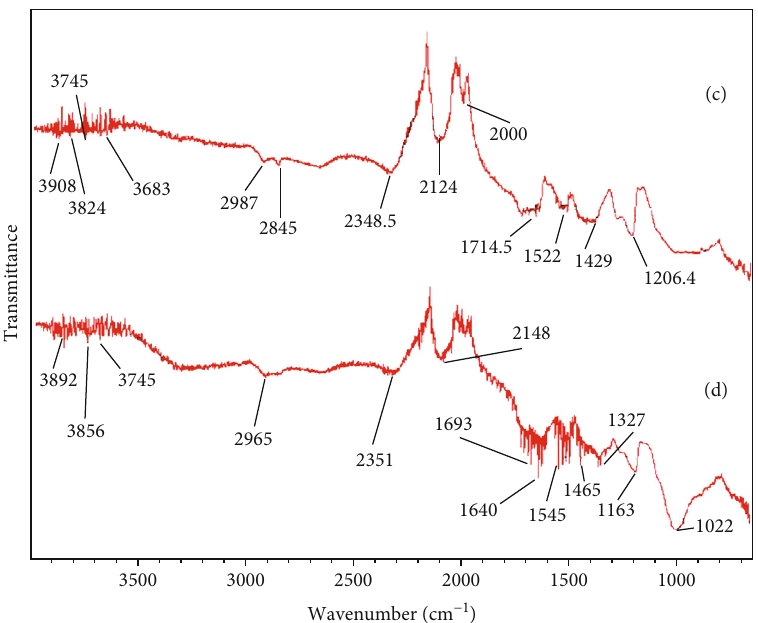
Figure 5: Comparative FT-IR characterization of citric acid-treated adsorbents ((c) CPWM and (d)